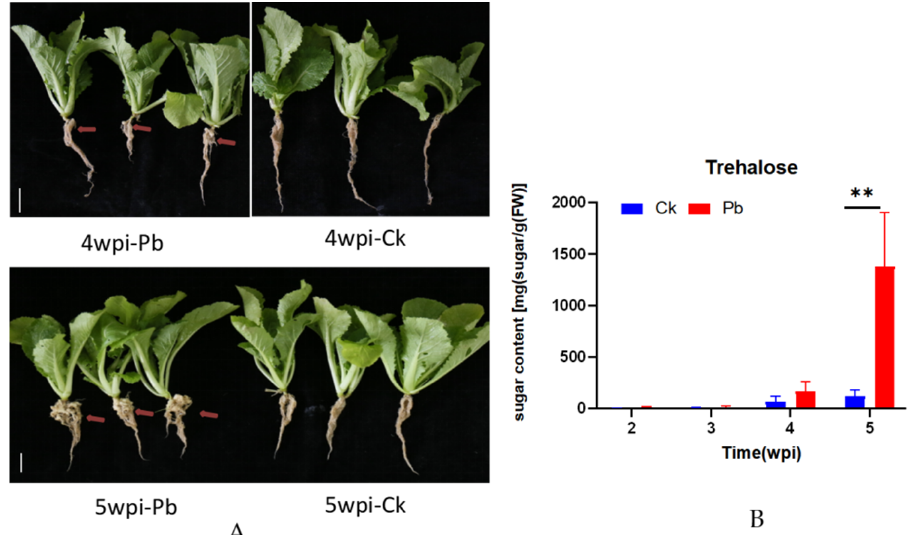
Figure 1. Phenotypic investigation and trehalose contents in the roots of Chinese cabbage after plasmodiophora brassicae inoculation. CK: inoculation-distilled water; Pb: inoculation with P. brassicae. ( A ) Investigation of clubroot disease of roots at 4 and the 5 weeks post-inoculation (wpi) with P. brassicae. The red arrow points to the location of the clubroot disease. The white scale range represents 2 cm. ( B ) The trehalose contents in the roots of Chinese cabbage after P. brassicae inoculation. The abscissa represents the time post-inoculation, and the ordinate represents the value of sugar content. The data represent mean values ± SDs. The asterisks indicate p -values (** p < 0.01) according to Student’s t test. Horizontal axis is the time point from 2 weeks to 5 weeks post-inoculation (wpi). A total of three TPS genes were acquired by keyword search against the P. brassicae genome in NCBI’s nr database, namely PbTPS1 , PbTPS2 , and PbTPS3 . The coding sequence length of the three PbTPS genes was longer than 2500 bp, and the length of the amino acid ranged from 853 to 860 aa. The molecular weight ranged from 95.50 to 96.49 kDa, and the predicted pI value ranged from 6.18 to 6.93. Subcellular localization prediction indicated that the three PbTPS proteins were located in the cytoplasm (Table